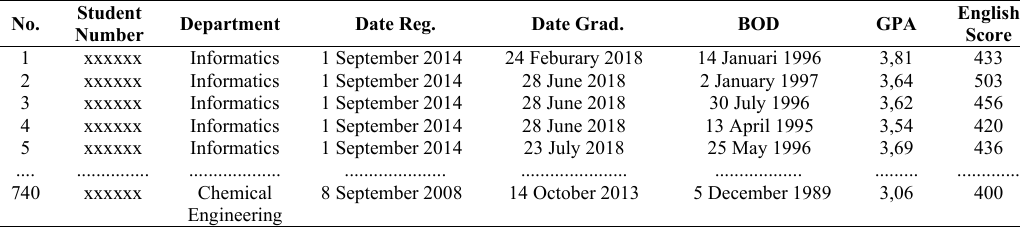
TABLE 1 S AMPLE OF S TUDENT D ATA FOR A CADEMIC Y EAR